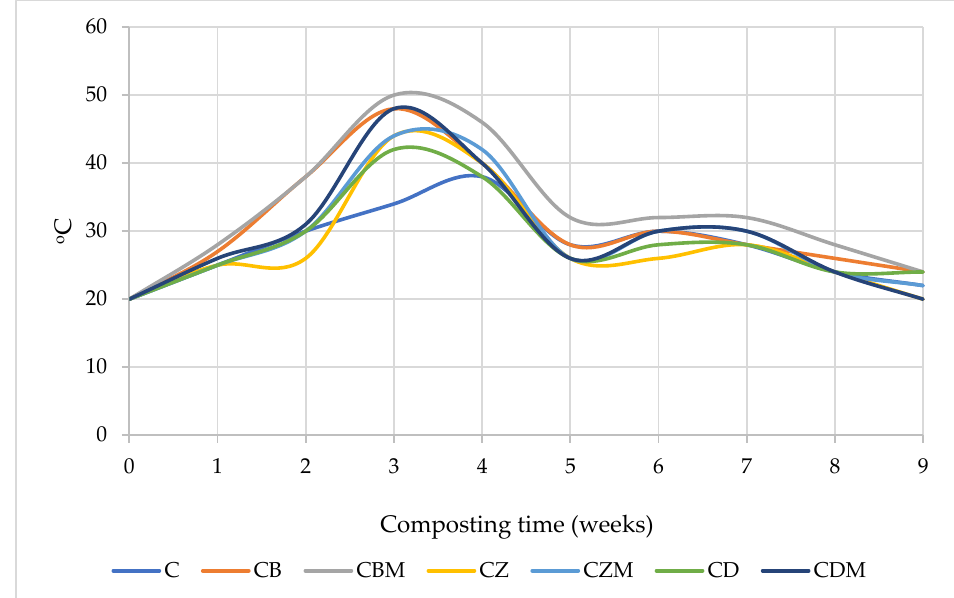
Figure 1. Temperature changes during composting. C—biomass without the addition of functional- ized materials and bacterial metabolites, CB—biomass with the addition of biochar, CBM—biomass with the addition of biochar and bacterial metabolites, CZ—biomass with the addition of zeolite, CZM—biomass with the addition of zeolite and bacterial metabolites, CD—biomass with the addition of diatomite, CDM—biomass with the addition of diatomite and bacterial metabolites.